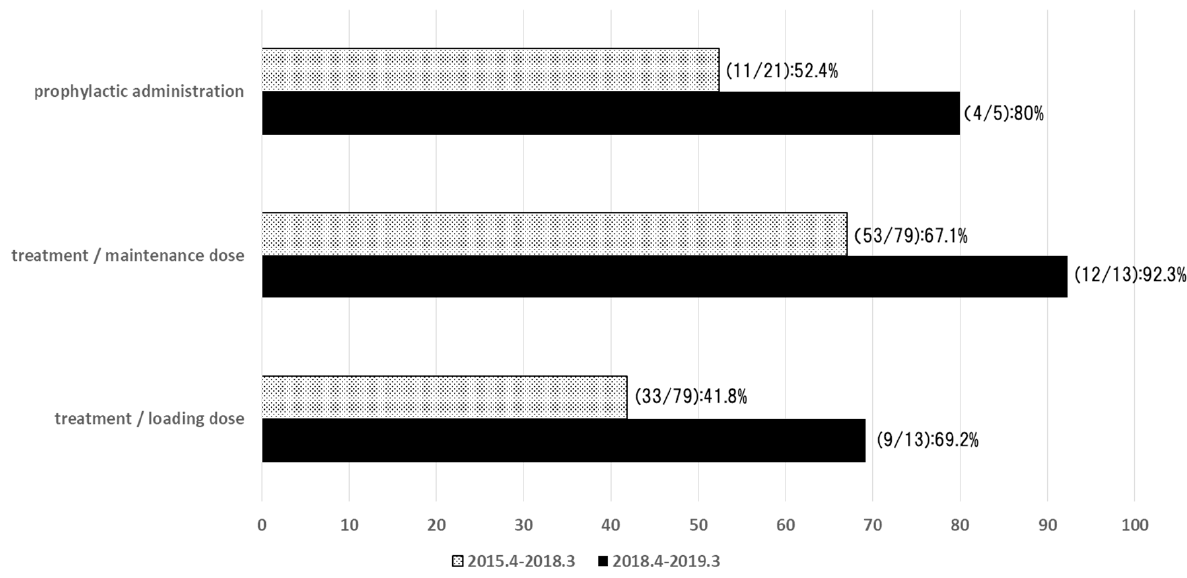
Figure 2. The rate of adherence to the standard dose of voriconazole. The survey was conducted at our hospital between April 2015–March 2019. Overall, data from 118 patients were reported [61].